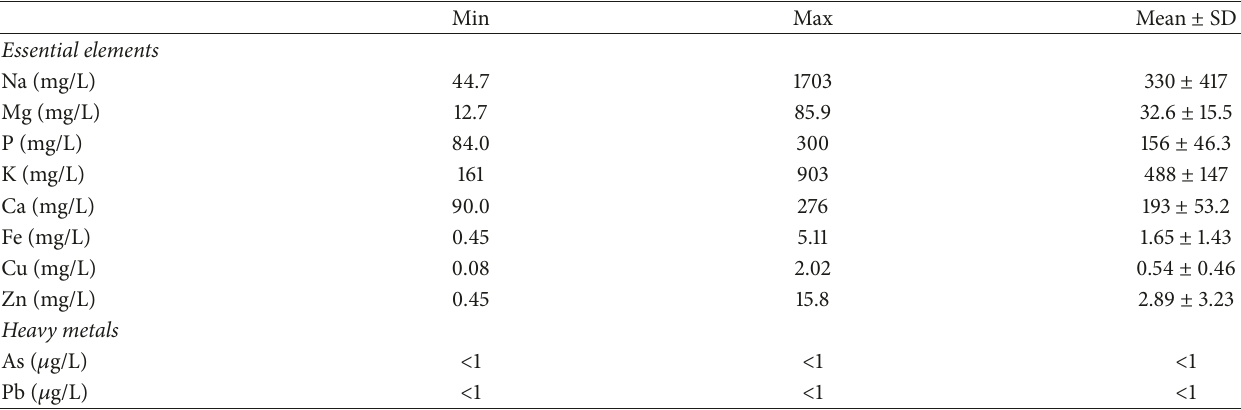
Table 3: Concentration of essential elements and heavy metals of MBM samples.